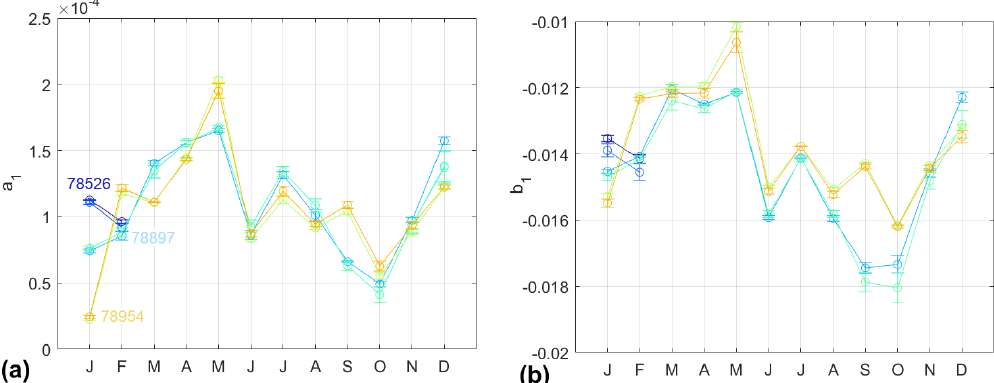
Figure 4. Monthly estimates of the polynomial coefficients for the slope (a) and the offset (b) according to Eqs. (6a) and (6b), respectively, limited to order 1. The different curves show results for three different radiosonde stations (labelled by their WMO codes: 78897, 78954, and 78526) and two regression methods (OLS and WLS). The OLS and WLS results are almost superposed and are not labelled. Note that for station 78526 only 2 months of observations (January and February) were available in 2020. The error bars indicate the 95% confidence interval for each estimated parameter.